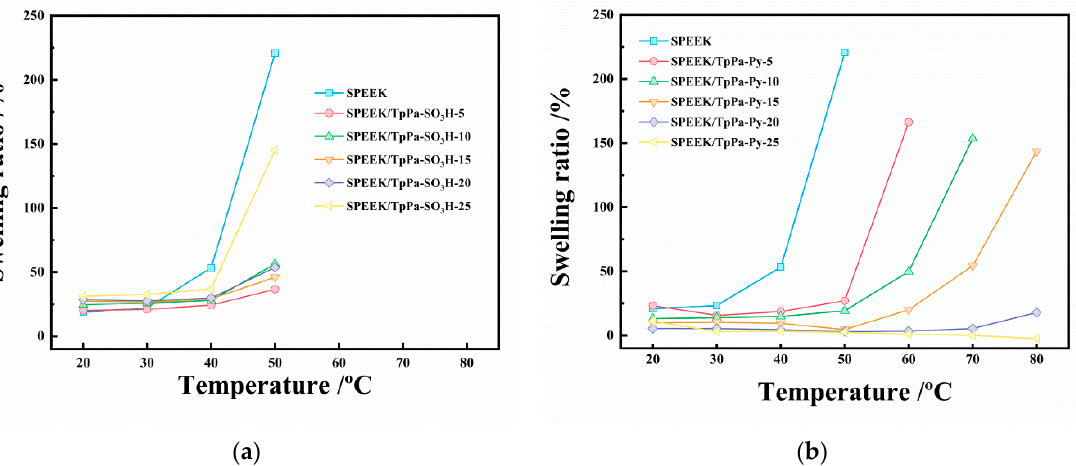
Figure 4. Swelling ratio of ( a ) SPEEK and SPEEK/TpPa − SO 3 H, ( b ) SPEEK and SPEEK/TpPa − Py at different temperatures under 100% RH.